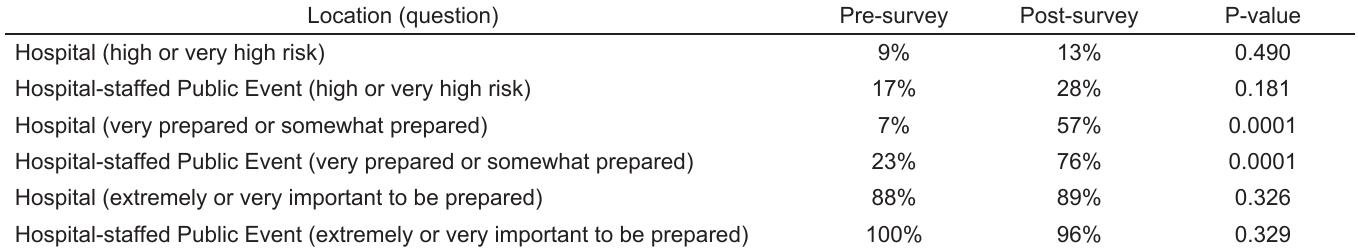
Table 4. Pre- and post-survey results: perceived risk by location, current level of preparedness by location, and the importance of each location being prepared for active shooter events.